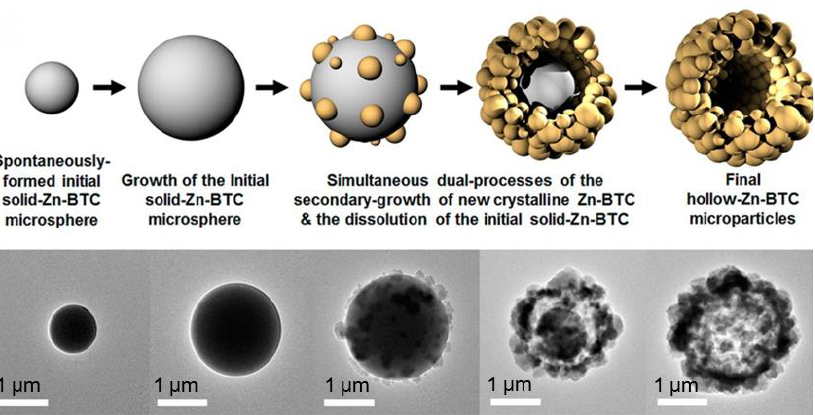
Figure 4. Fabrication of HRP@H – ZIF – 8 – GOx. Reprinted with permission from Ref. [36]. Copyright 2019, American Chemical Society.